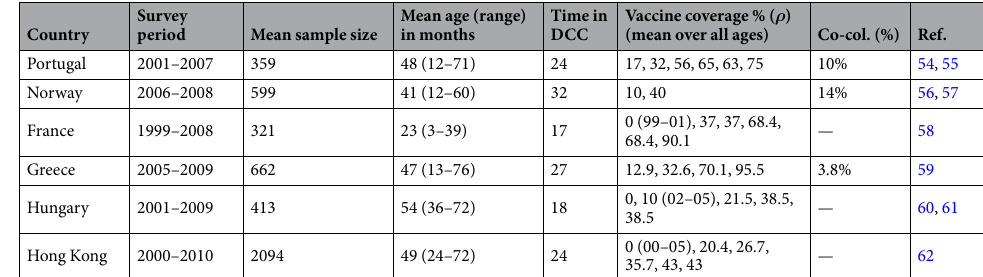
Table 1. Characteristics of the studies in daycare settings from different countries before and after PCV7 vaccination. Mean age of children in each study and expected duration of DCC attendance (see S2.2 for details) are given in months. Vaccination proportions per year were extracted from the children that that received at least one dose of PCV7 across the studies. When information on vaccination coverage for intermediate years was missing, the same value as in the preceding year was assumed.